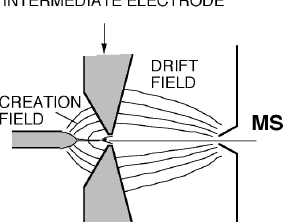
Figure 3 . Basic Design using an Intermediate Electrode.